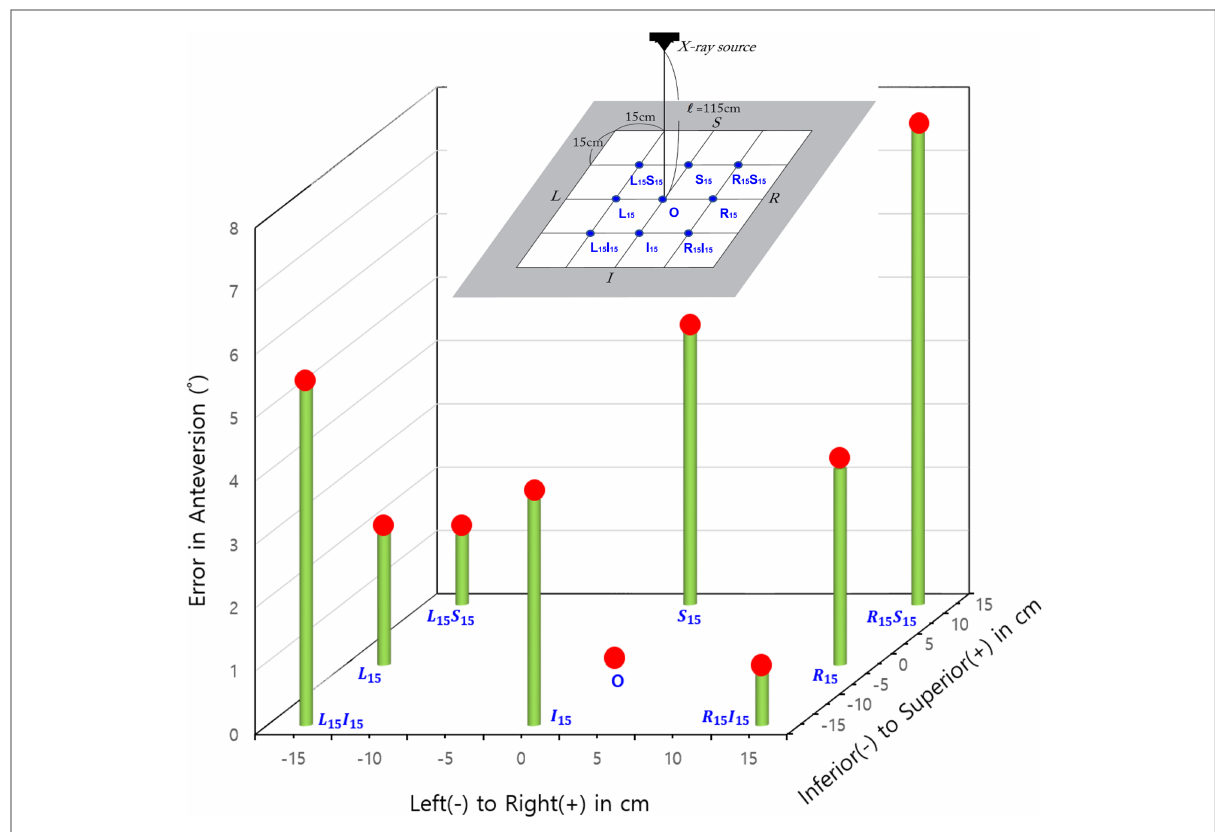
FIGURE 9 Errors (in absolute values) in the acetabular anteversion for the femoral head ’ s spatial eccentricity modes in the original